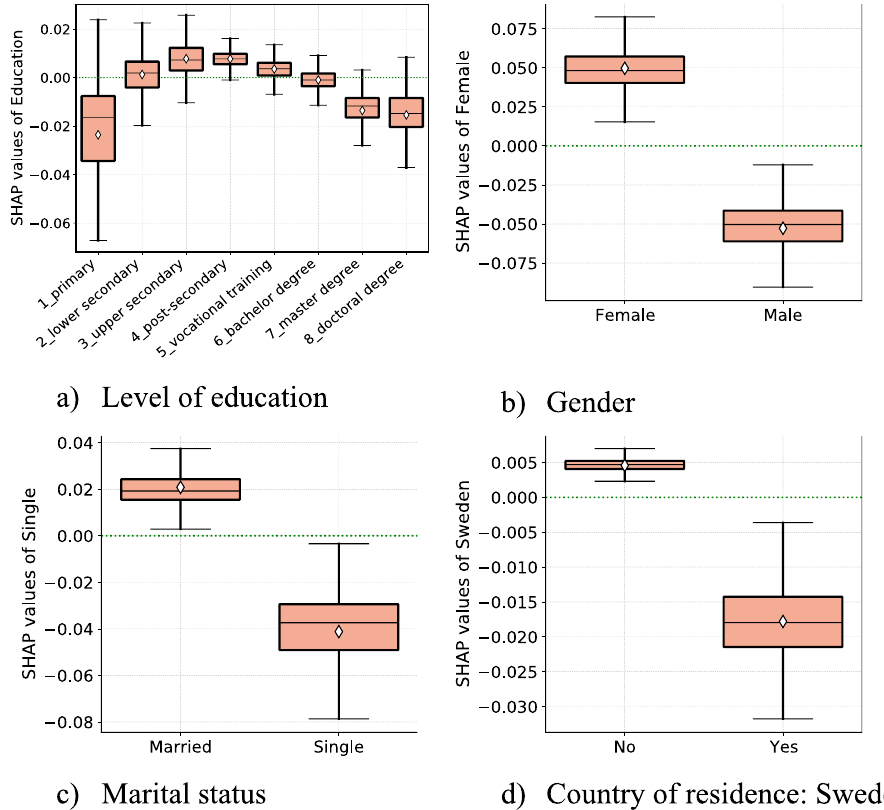
Figure 6. Partial effects of socio-demographic factors. Notes : Each panel ( a )–( d ) display SHAP dependence boxplots of socio-demographic features. The diamond symbol in the boxes denotes the average of SHAP value distribution per each